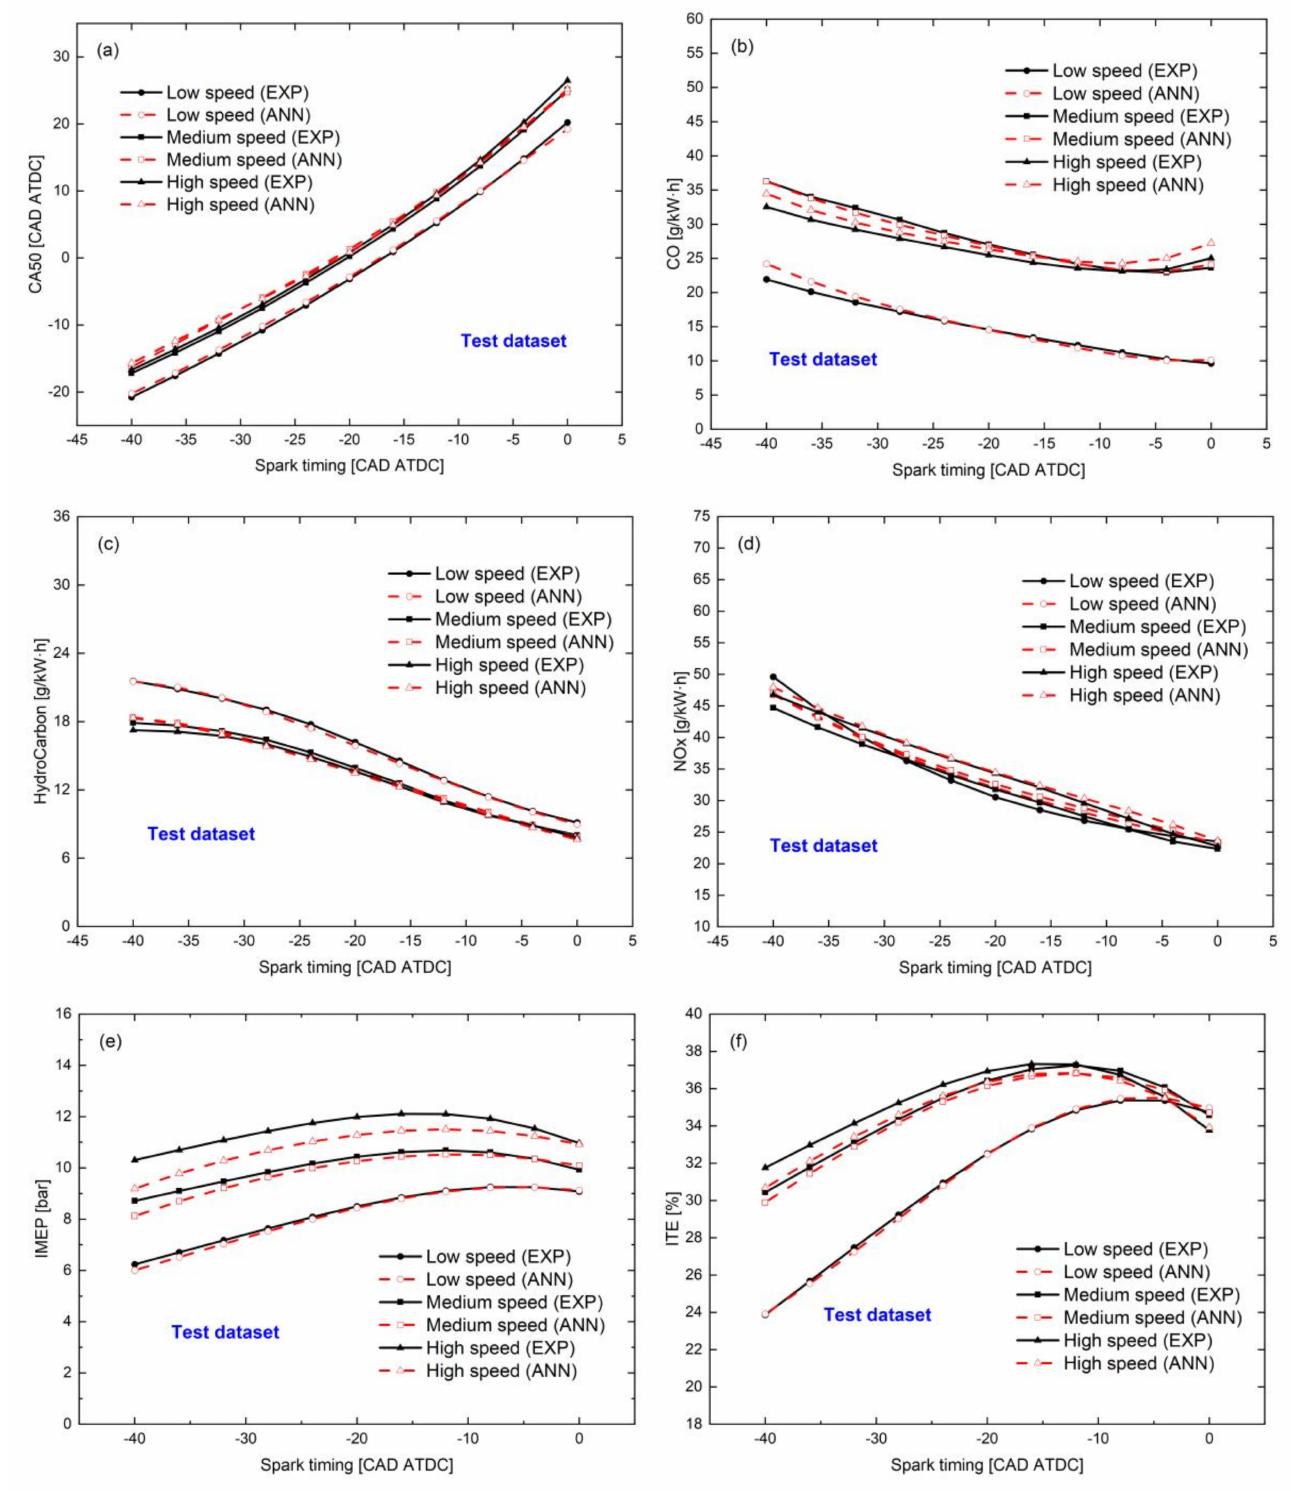
Figure 7. Comparison of ANN model predicted performance and emissions with calibrated data under high load for the steady test dataset: spark timing effects: ( a ) CA50, ( b ) CO, ( c ) UHC, ( d ) NOx, ( e ) IMEP, ( f )